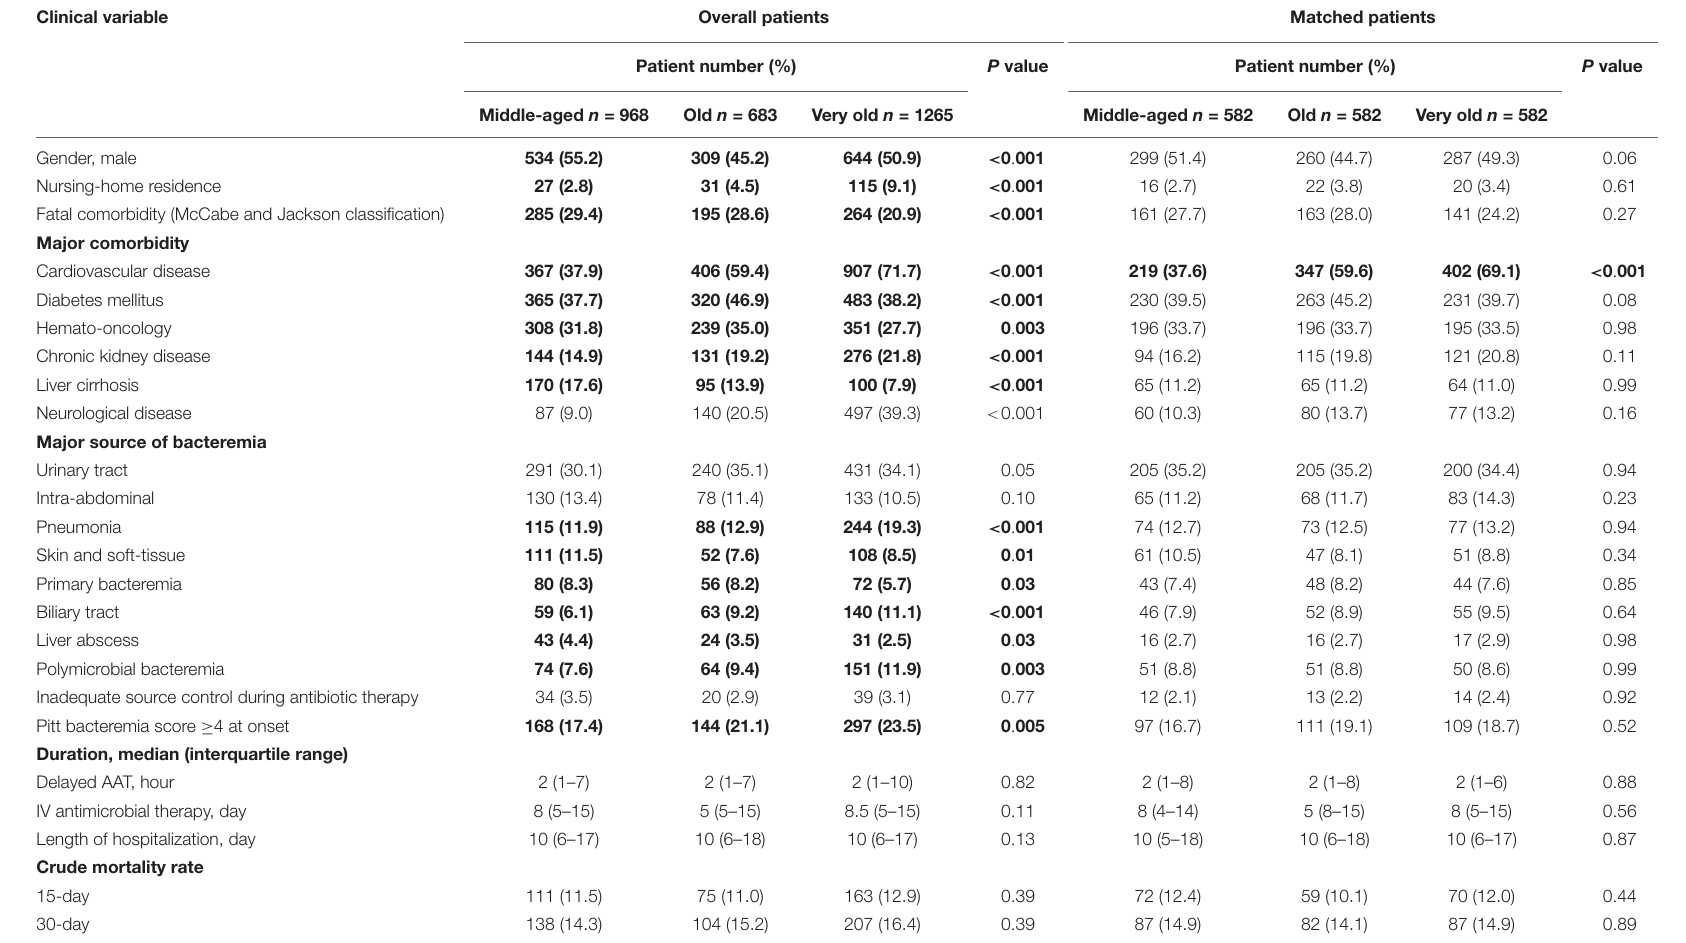
TABLE 1 | Clinical characteristics and outcomes of the overall and propensity-score-matched adults in varied age groups*. Clinical variable Overall